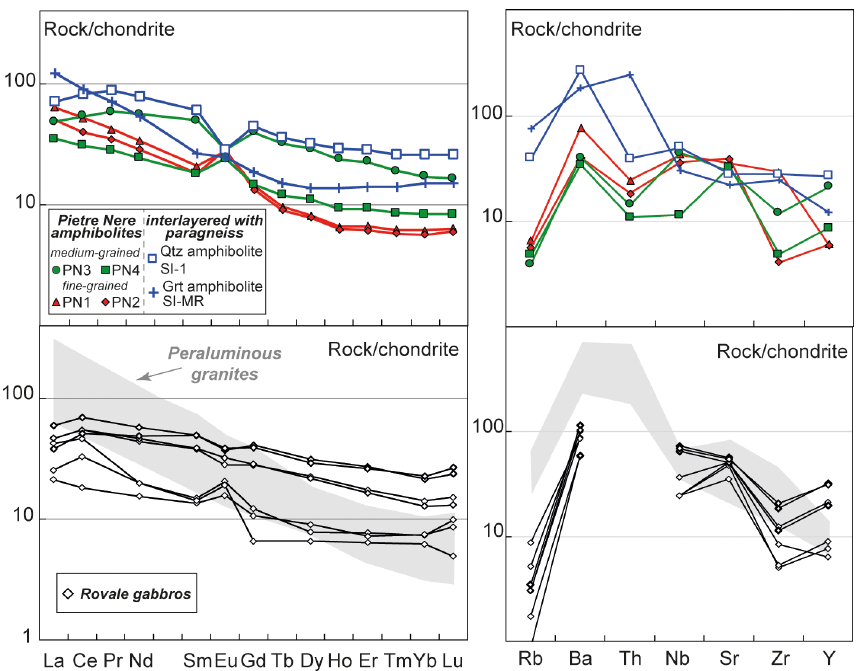
Figure 11. Trace-element whole-rock variation normalized to chondrite (Anders and Ebihara, 1982). The compositions of Rovale gabbros (Sila Massif, Caggianelli et al., 1994) and late-Variscan peraluminous granites (grey field, central and southern Calabria, Rottura et al., 1993; Fiannacca et al., 2019) are reported for comparative